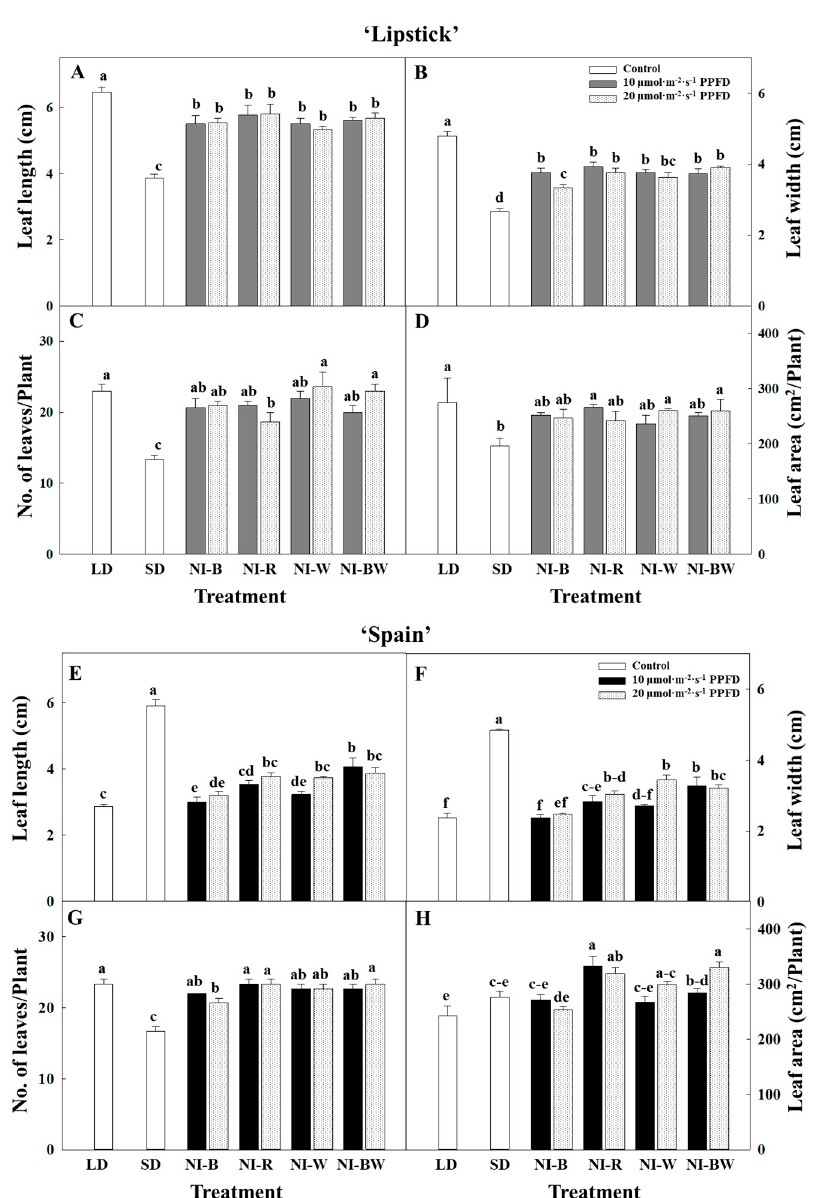
the Duncan’s multiple range test at P ≤ 0.05.